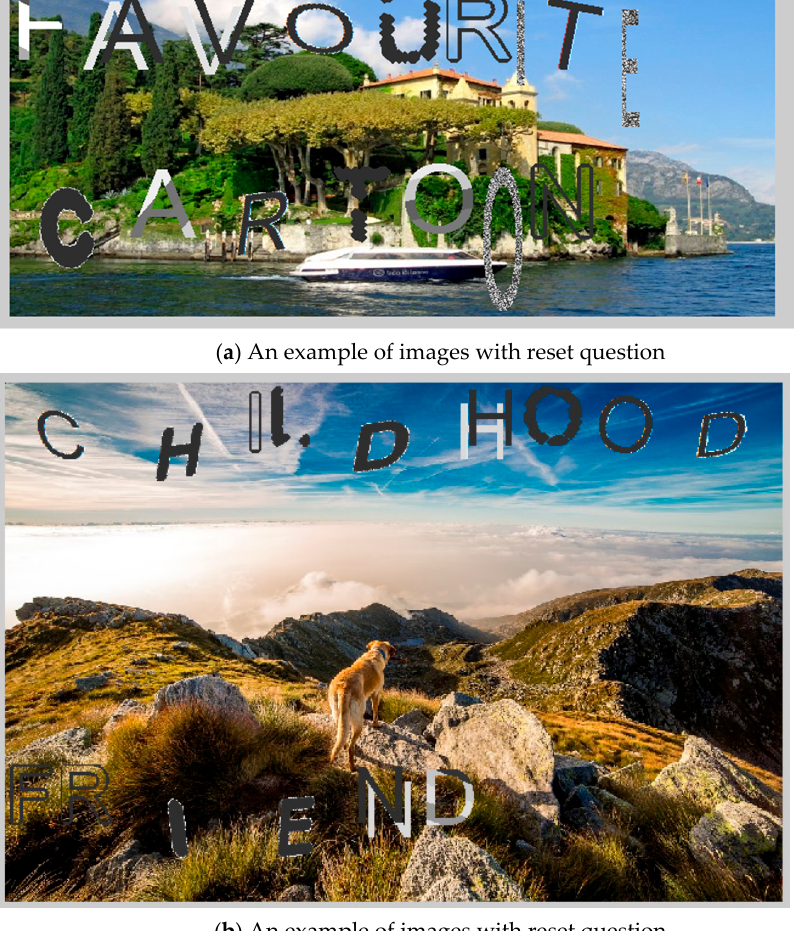
Figure 2. CAPTCHA password reminder images with password reset questions embedded into them.